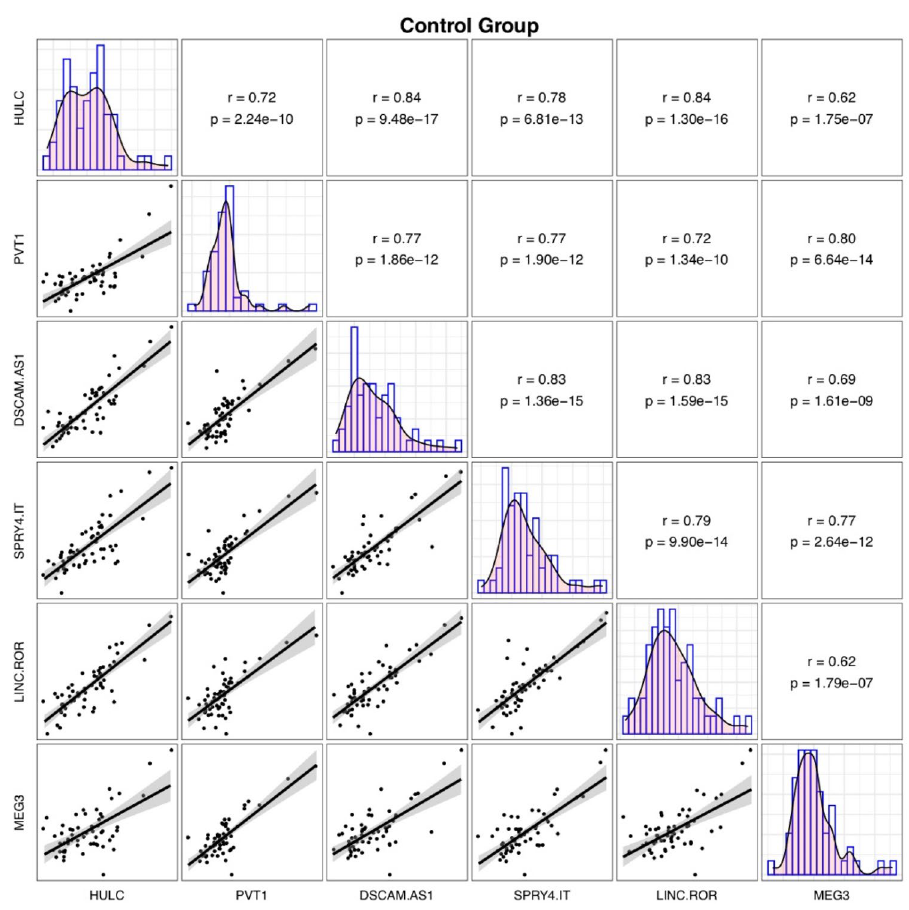
Figure 3. Correlations between expression quantities of lncRNAs among healthy controls. (This figure has been depicted by R software) 20